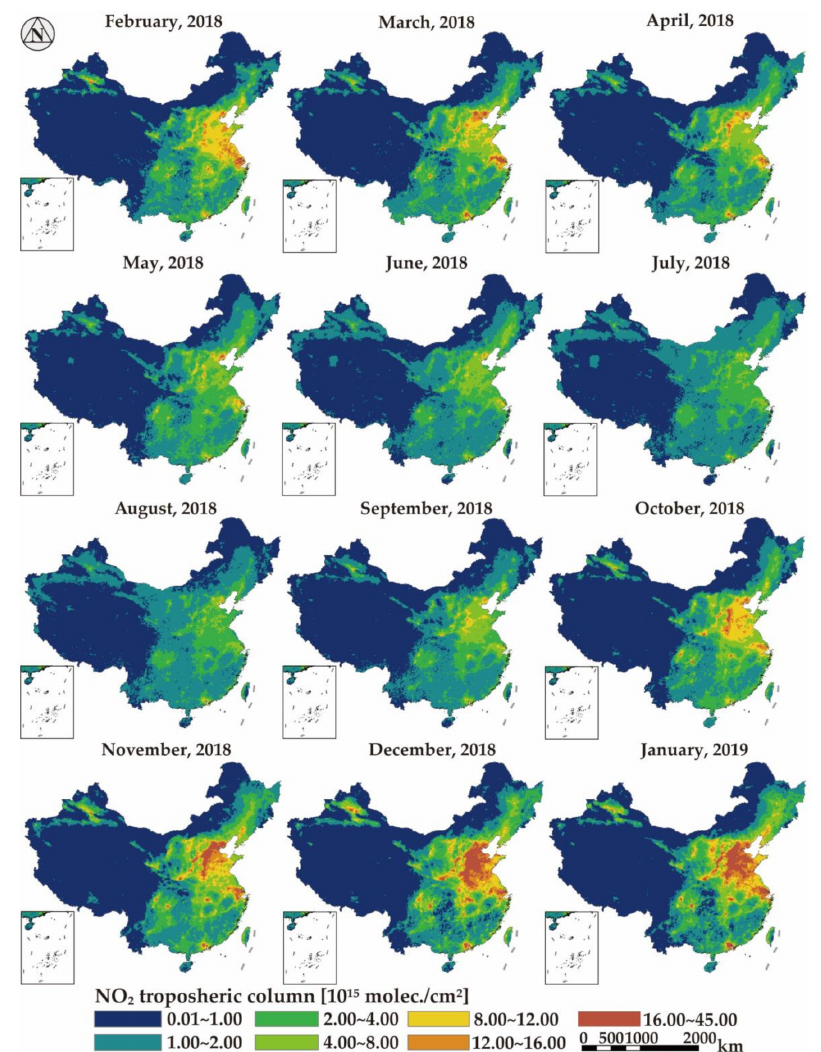
Figure 4. The monthly fixed images of tropospheric NO 2 column concentration in